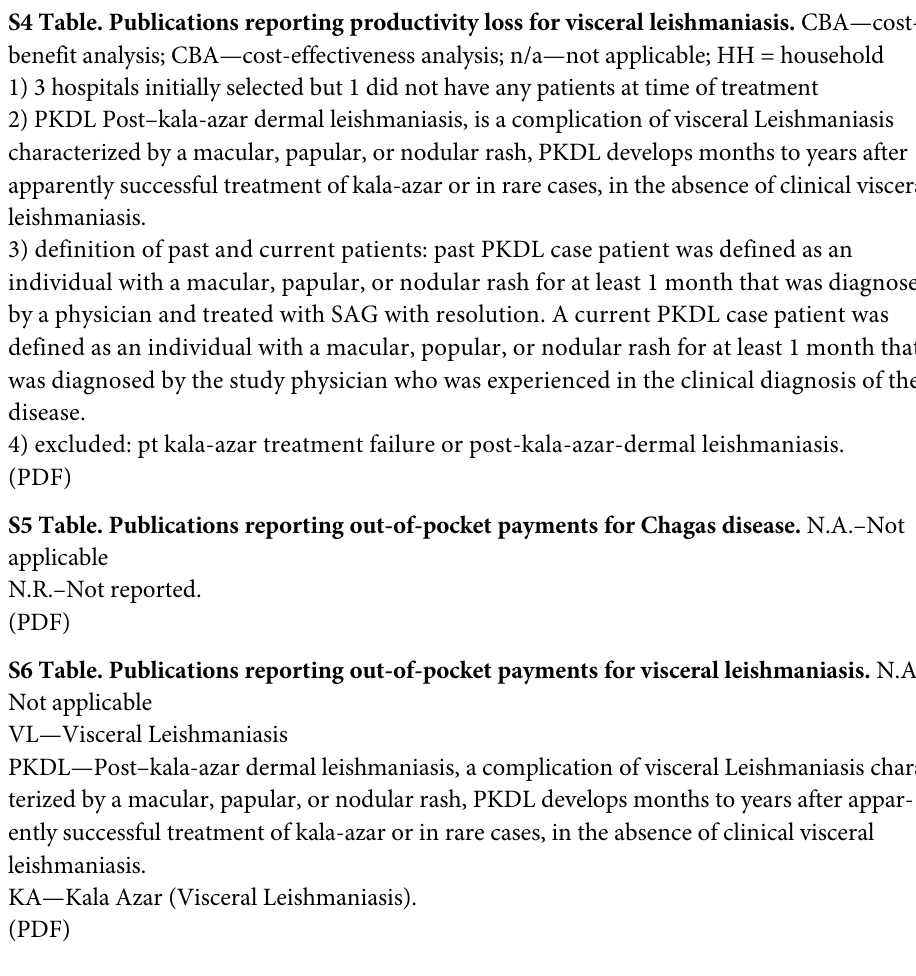
S1 Table. Results of database searches. The literature review yielded 11449 hits, 5316 after duplicates were excluded, for the 10 NTDs cited in the London Declaration. S2 Table. Literature review—Results per disease. The paucity of studies that provide quanti- tative estimates of productivity loss and OPPs from NTDs can be seen in the table above. (PDF) S3 Table. Publications reporting productivity loss for Chagas disease. NA—Not applicable NR—Not reported